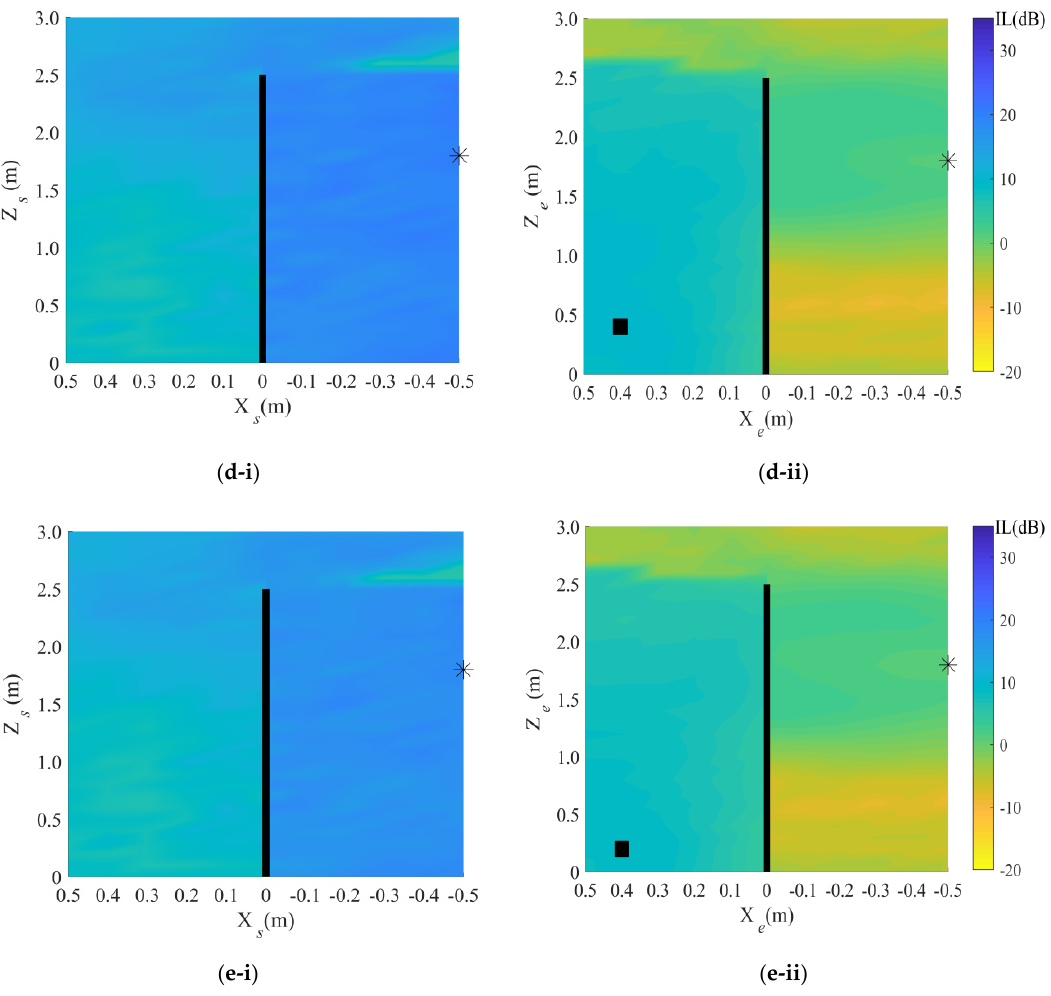
Figure 4. IL s (dB) for different positions of ( i ) secondary sources and ( ii ) error microphones, in the control zone. The distance of the noise source from the barrier ( d pr ) is ( a ): 1 m, ( b ) 2.5 m, ( c ) 4 m, ( d ) 5.5 m, and ( e ) 7 m. The barrier is presented by the black bar, and * and ■ represent the best positions of the control sources and error microphones, respectively.